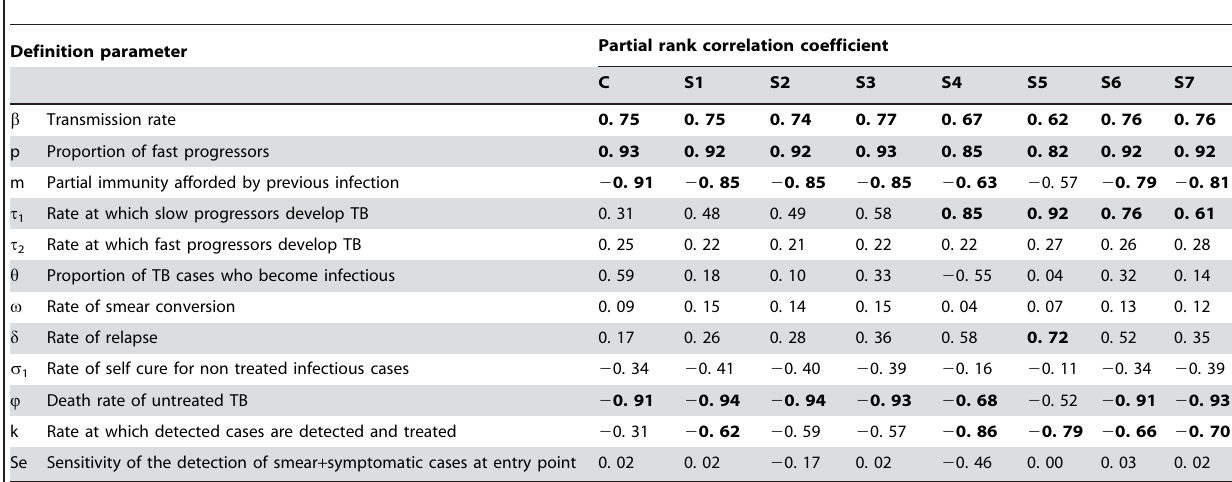
Table 4. Partial rank correlation coefficient (PRCC) between each parameter and the average predicted prevalence after 10 years, for the current scenario and TB control strategies